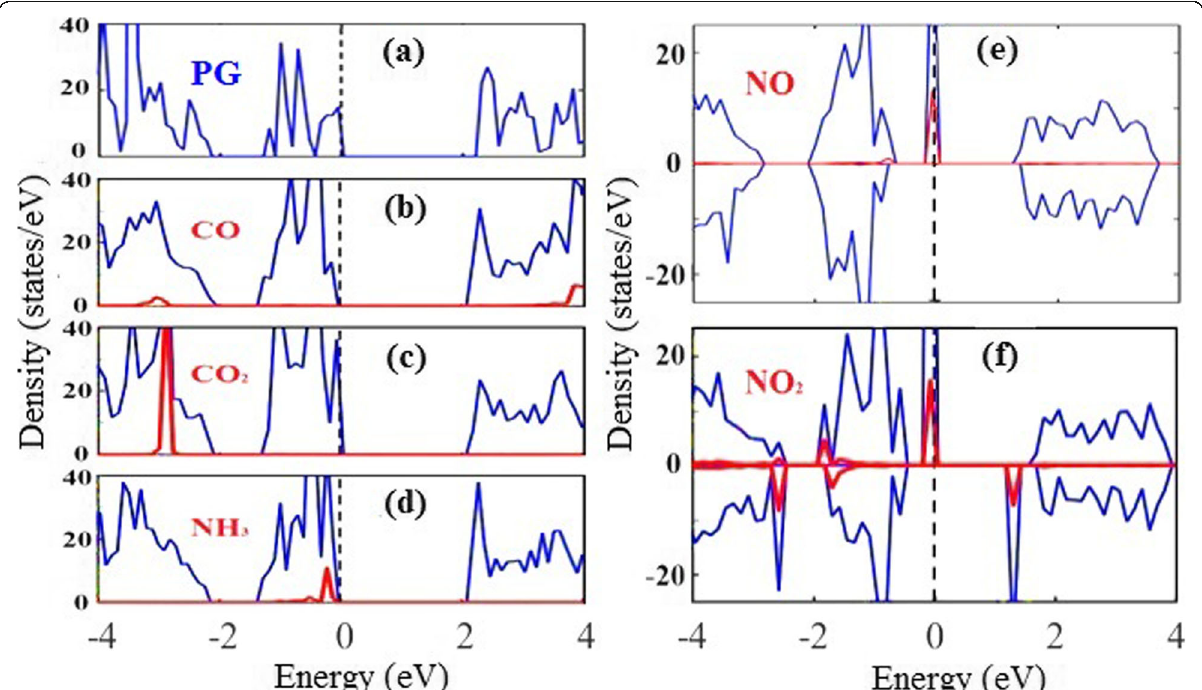
Fig. 3 Total electronic density of states. a The DOS of pristine penta-graphene. b – f Total DOS of penta-graphene with each gas molecule adsorption (blue lines) and the partial DOS from the gas molecule (red lines). The Fermi level is taken to be zero and displayed with a black dashed